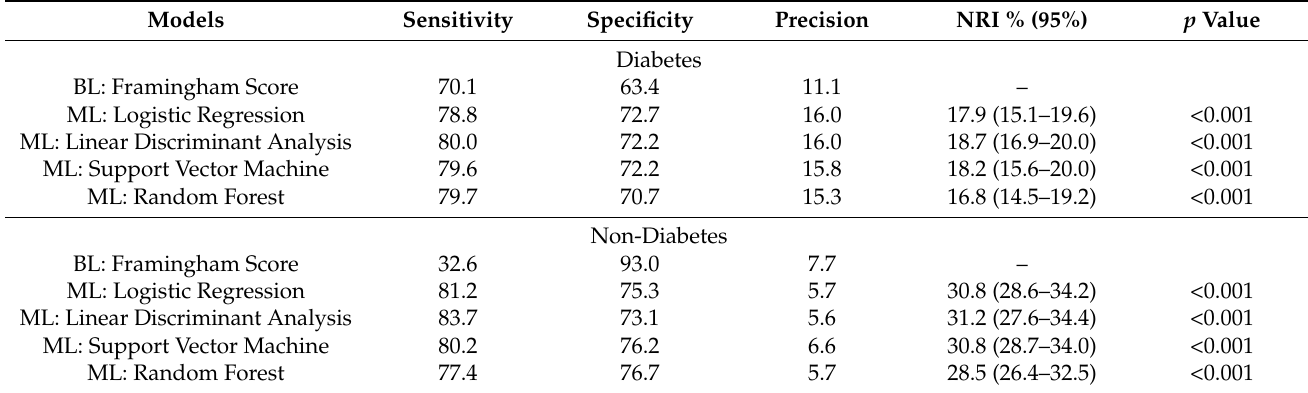
Table 9. Two-fold cross validation: Comparison of the classification (Sensitivity, Specificity, Precision) and NRI performance of Framingham Score (baseline model (BL)) and four machine learning (ML) models predicting 15-year risk of CVD mortality using combined data based on diabetes stratification.